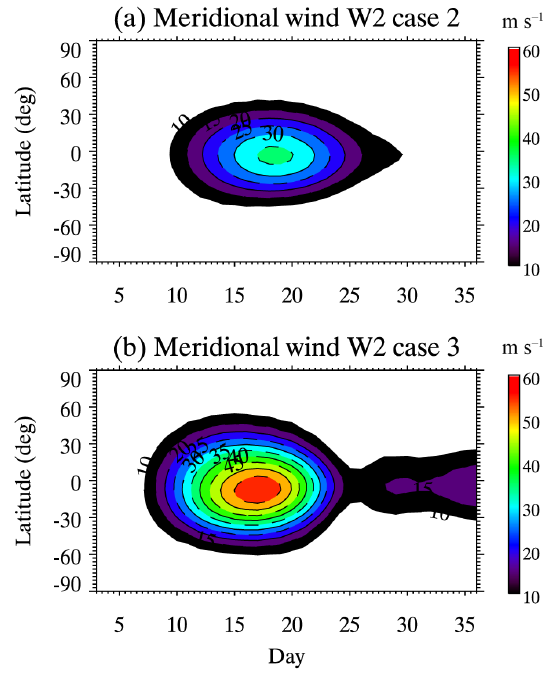
Figure 10. The temporal variations of the W2 at 100km for (a) case 2 and (b) case 3. The contour intervals are 5ms − 1